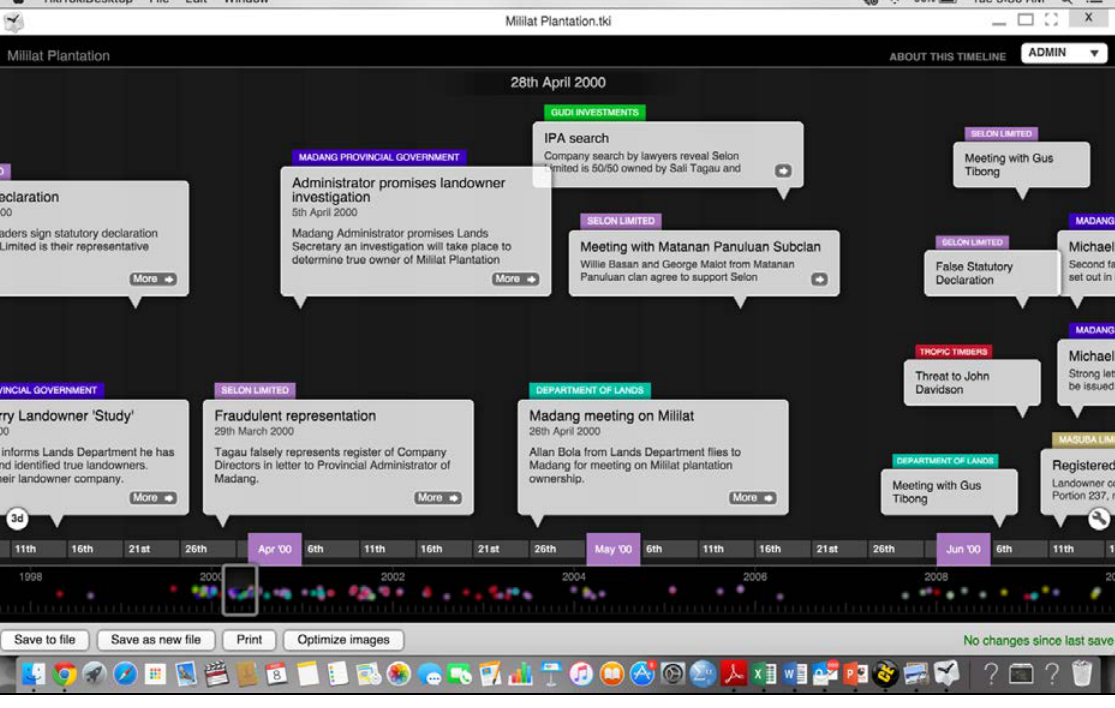
Figure 2: Modelling transaction data in